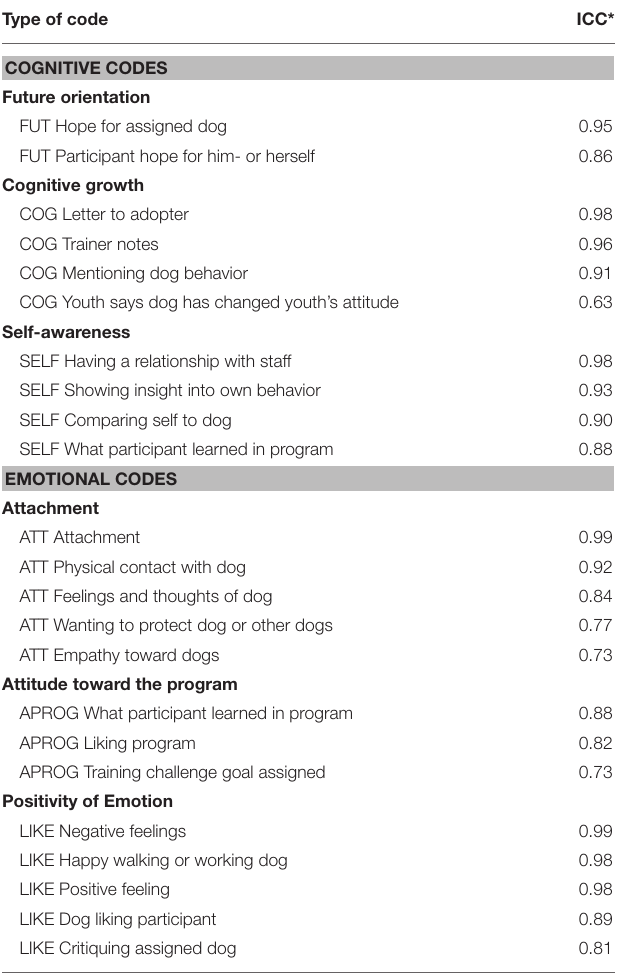
TABLE 2 | Sets of coding for participant journal